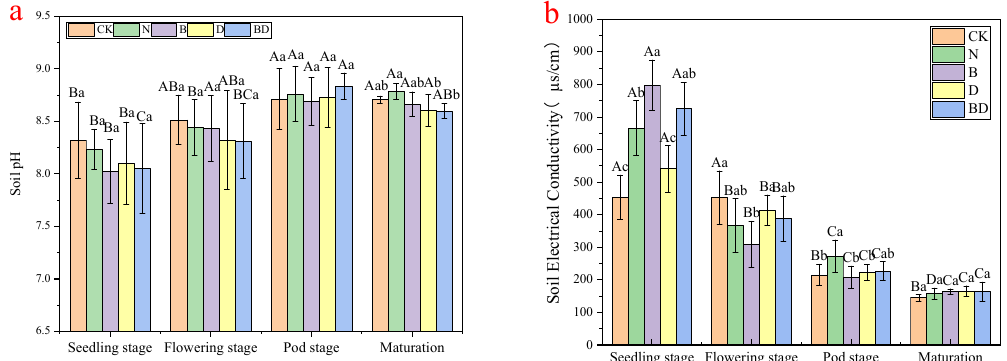
Figure 3. Effects of biochar and inhibitor addition on the soil’s pH ( a ) and the soil’s electrical conductivity ( b ). Small letters in the figure represent the significant difference among treatments in the same period ( n = 5, p < 0.05), while uppercase letters represent the significant difference among treatments in different growth periods (n = 5, p < 0.05).